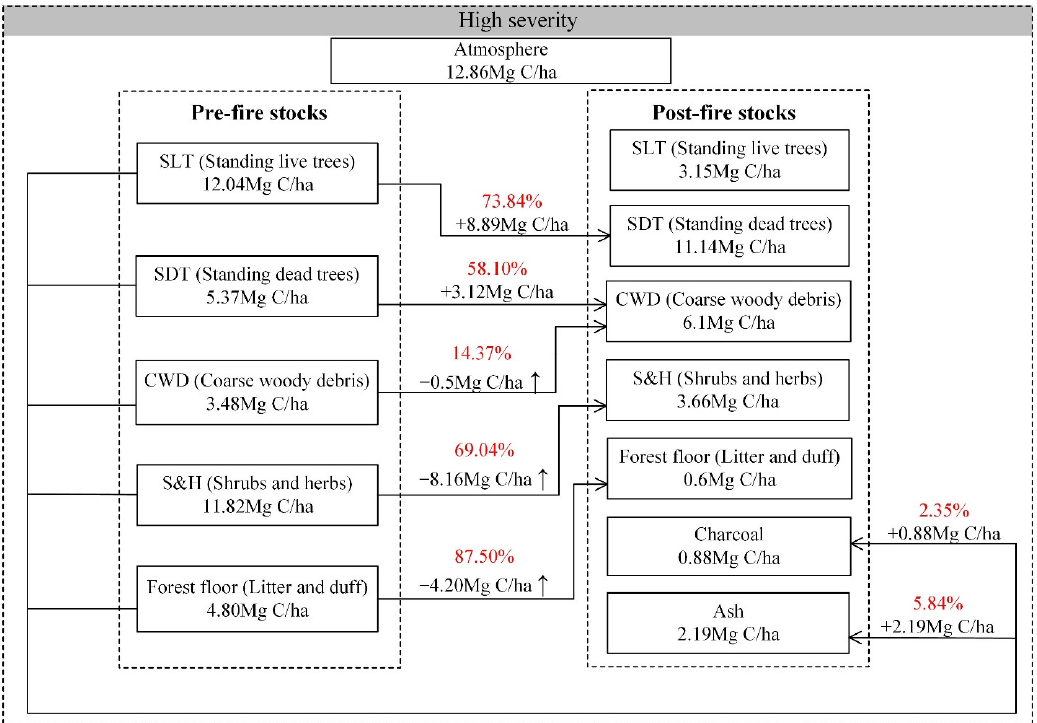
Figure 6. Carbon emissions, transfers, and ratios of changes for each aboveground carbon pool under moderate-severity fires.